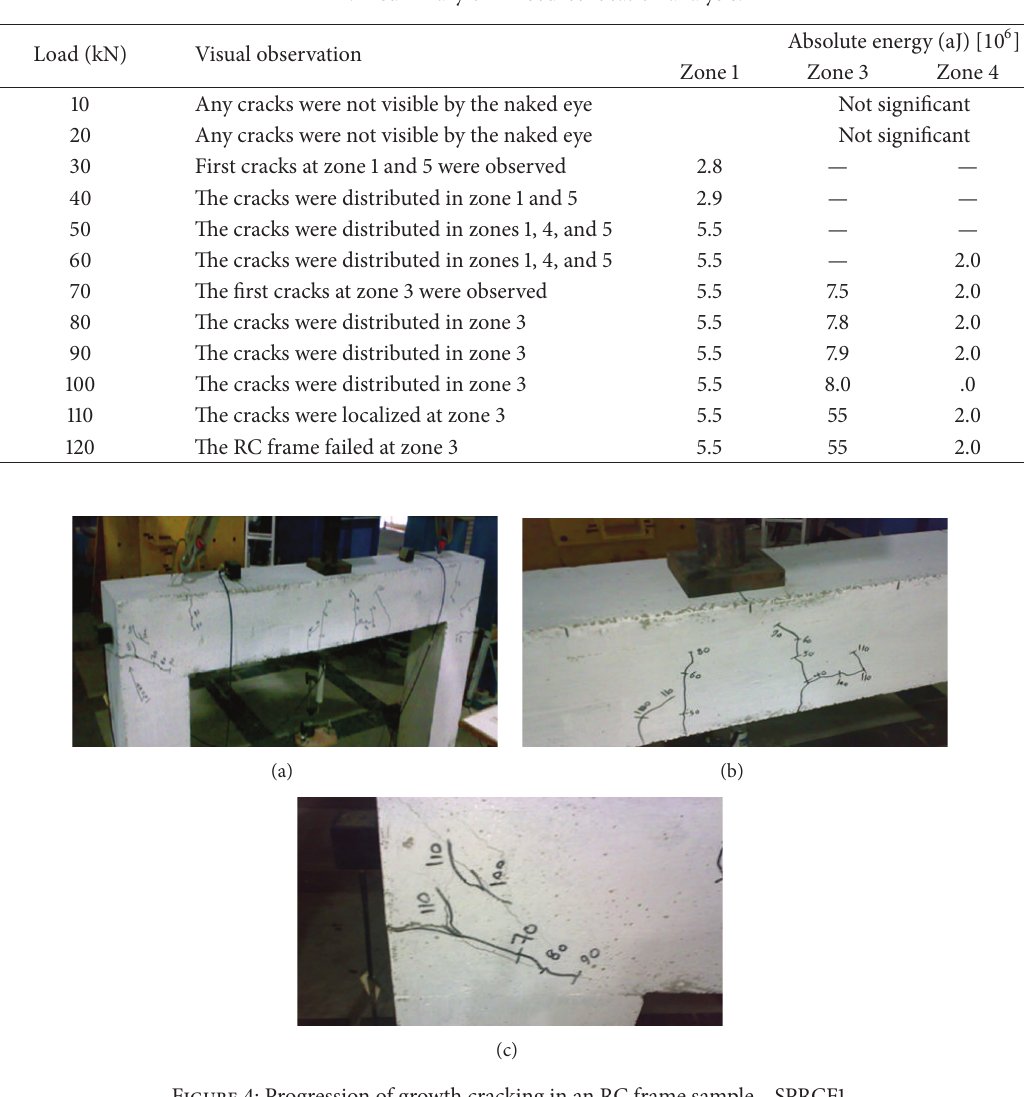
Figure 4: Progression of growth cracking in an RC frame